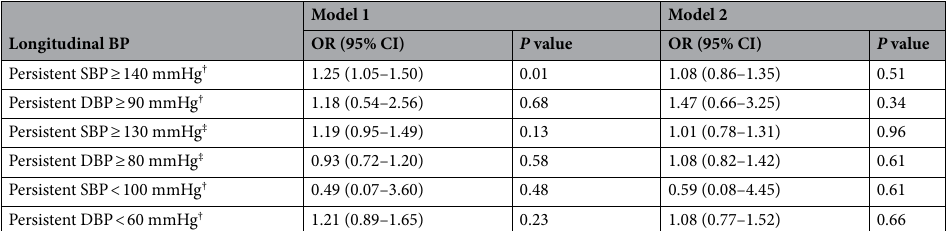
Longitudinal BP